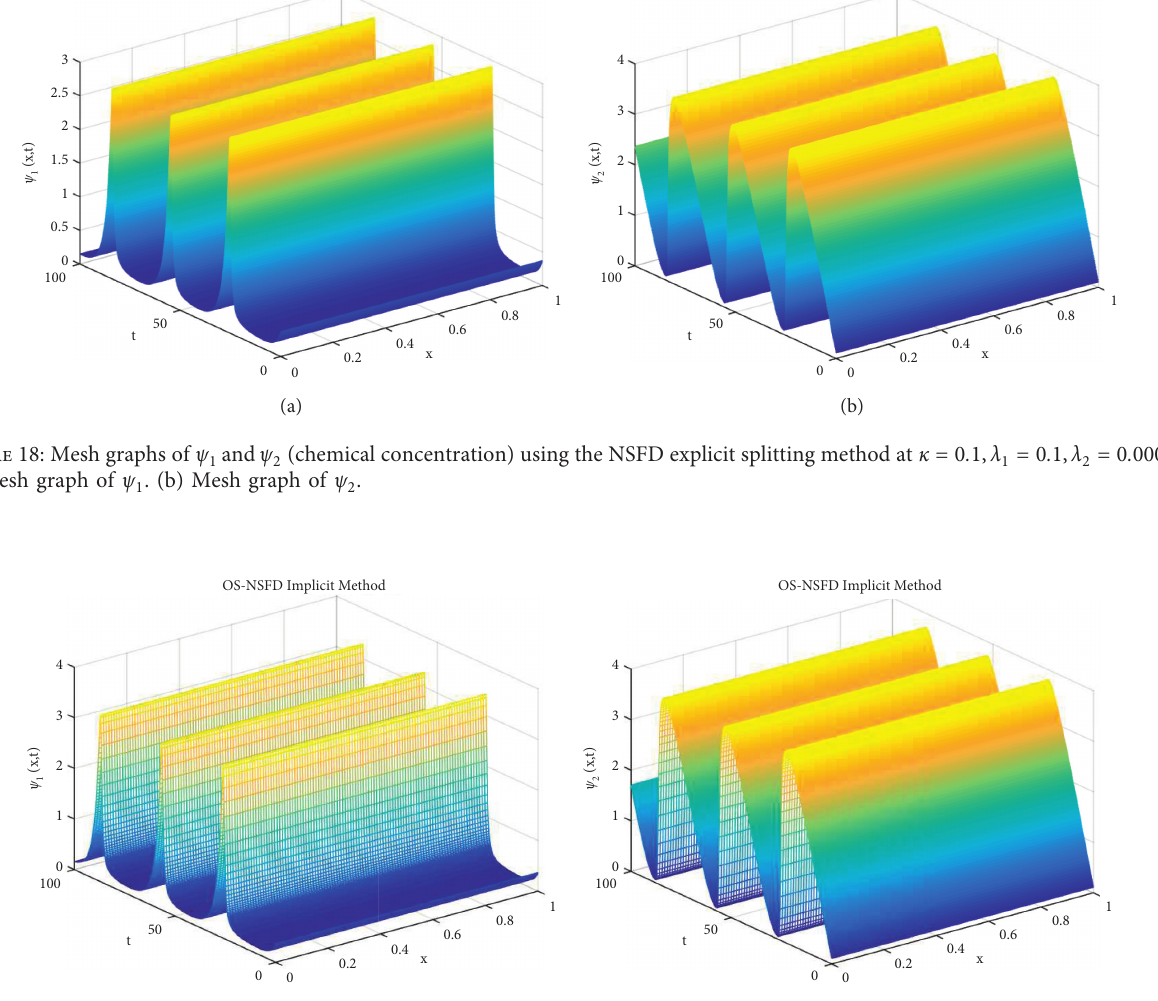
� 1000 , λ � 0 . 1. (a) 1 2